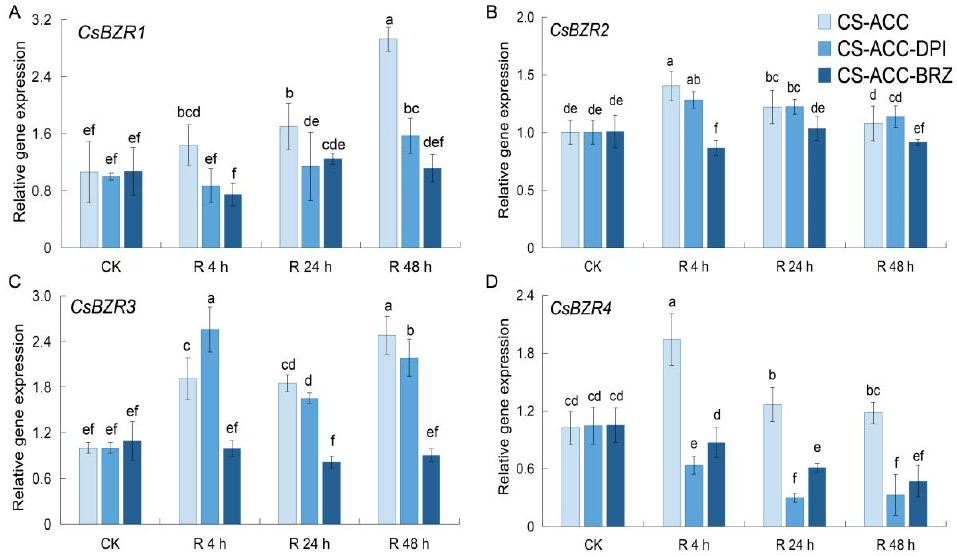
Figure 8. Inhibition of RBOH -dependent signaling or BRs during recovery after CS-ACC affected the expression of CsBZR1 ( A ), CsBZR2 ( B ), CsBZR3 ( C ) and CsBZR4 ( D ), respectively. CK: the con- trol, cucumber seedlings with no acclimation and at 25 °C during recovery; CS-ACC: seedlings were treated with a cold stress regime of 10 °C for 1 h, 25 °C for 1.5 h, and 1 °C for 3 h; CS-ACC-DPI: DPI